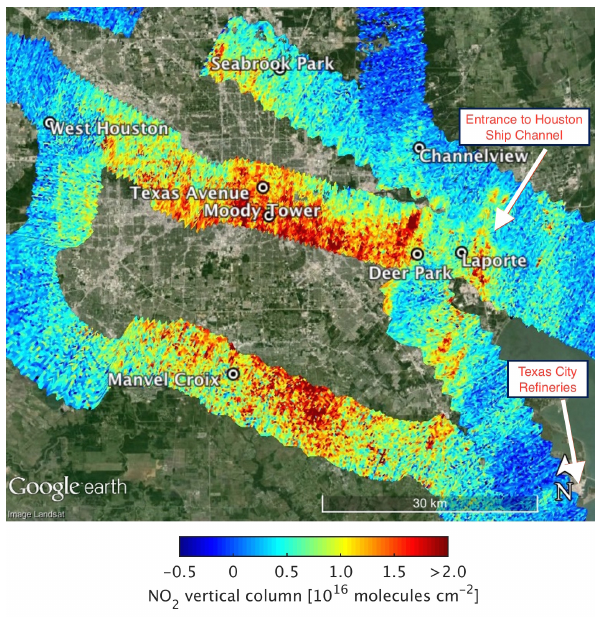
Figure 12. Enlarged view of Fig. 8a showing GeoTASO NO 2 tro- pospheric vertical columns during first Houston overpass on 13 September 2013 and DISCOVER-AQ ground stations in the cen- ter of the measurement region. The wave-like pattern in geolocation along the flight track is due to changes in instrument pointing from aircraft